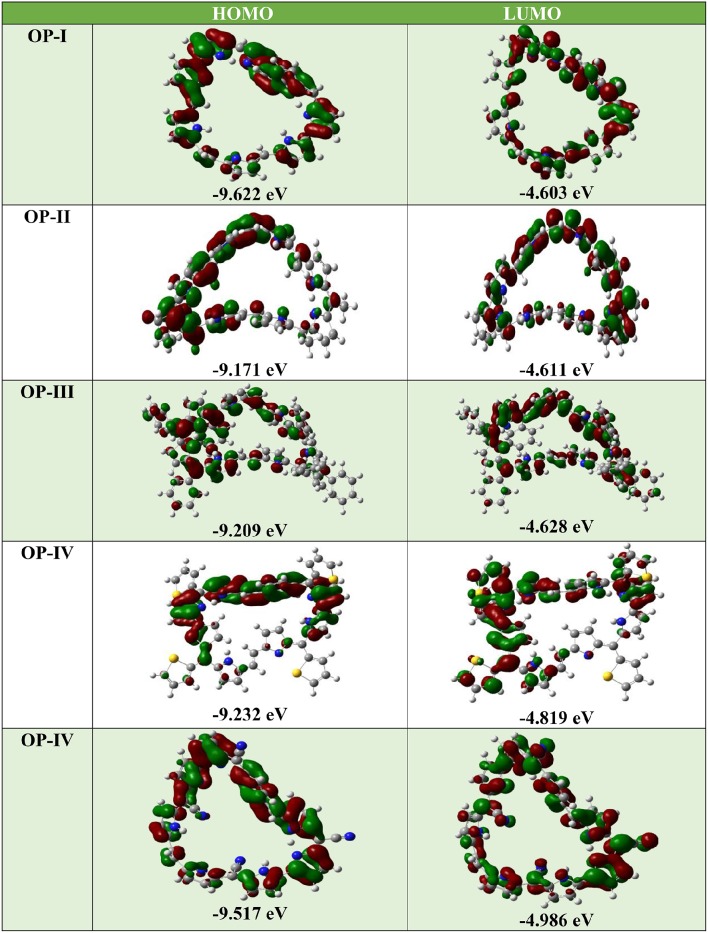
The frontier molecular orbitals (FMOs) of OP derivatives at DFT/ CAM-B3LYP/6-311++G (2d, 2p) level of theory.